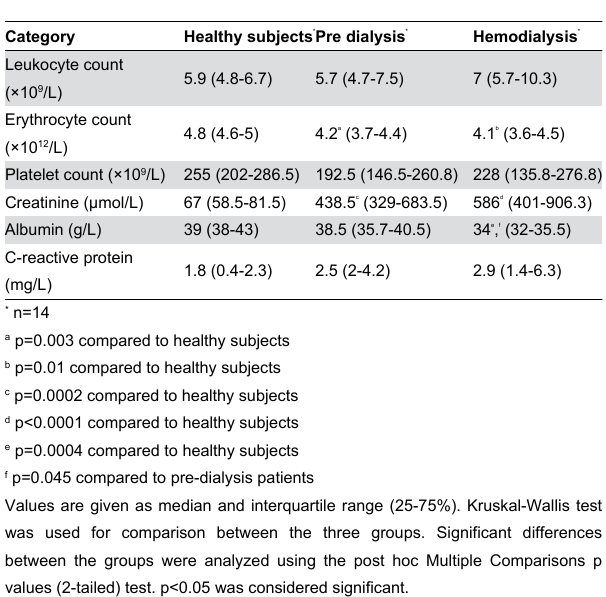
Table 5. Absolute number and percentage of CD8+ cells in the activated lymphoblasts